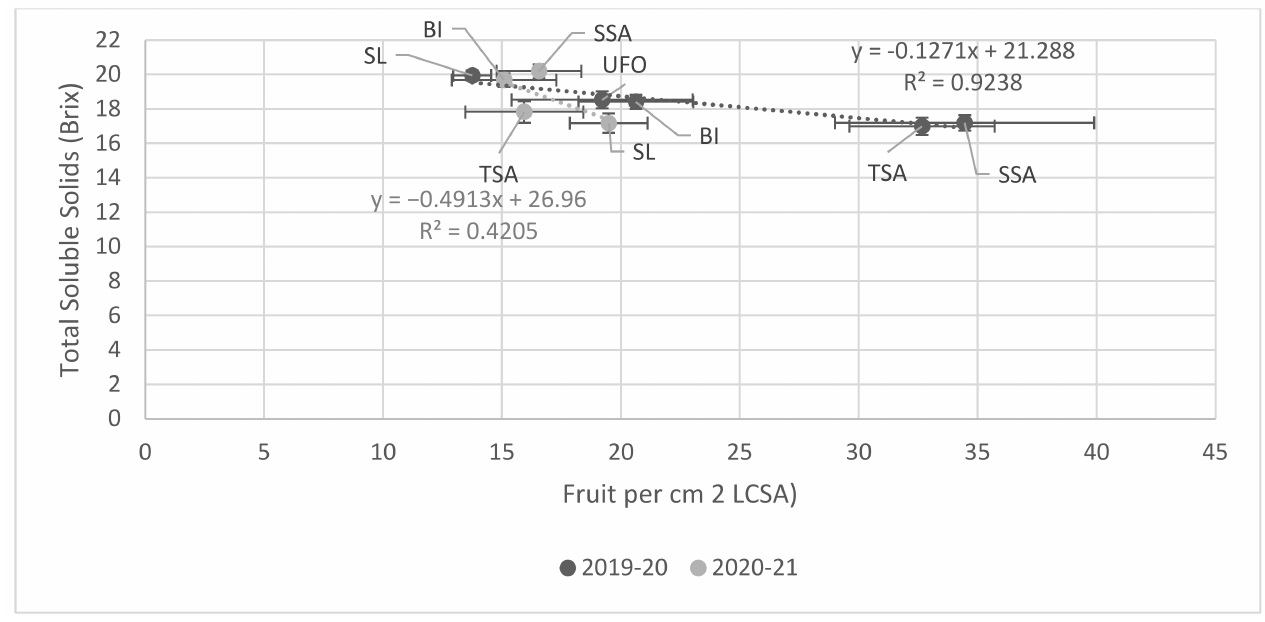
Figure 4. Correlation between crop load and fruit TSS of sweet cherry cultivar ‘Kordia’ across different training systems and seasons. Error bars represent one standard error for each training system and n = 6 for each system in a